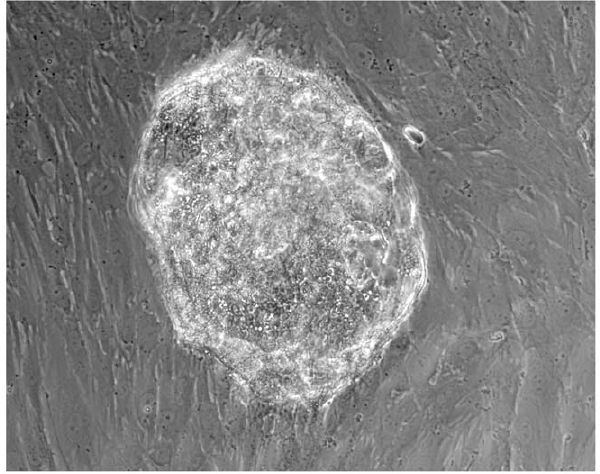
Figure 1. Embryo from co-culture. Human blastocyst attached to decidualized human endometrial stromal cells after 72 h of co-culture.